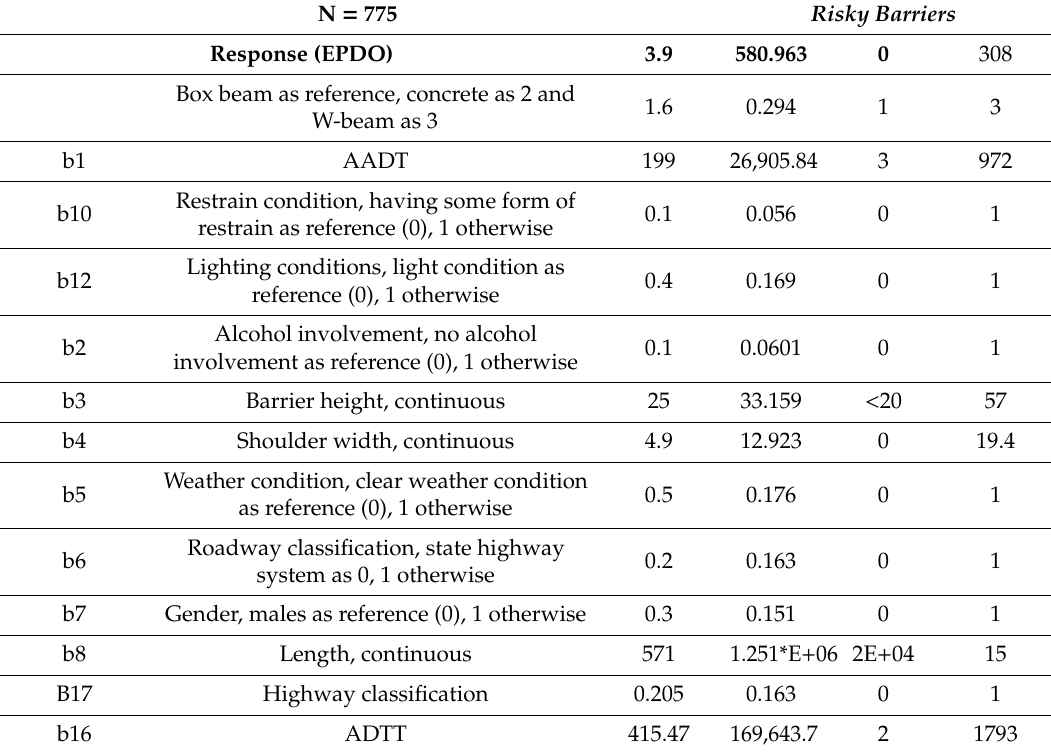
Table 2. Summary statistics of a data that a trained model is implemented on, under-design